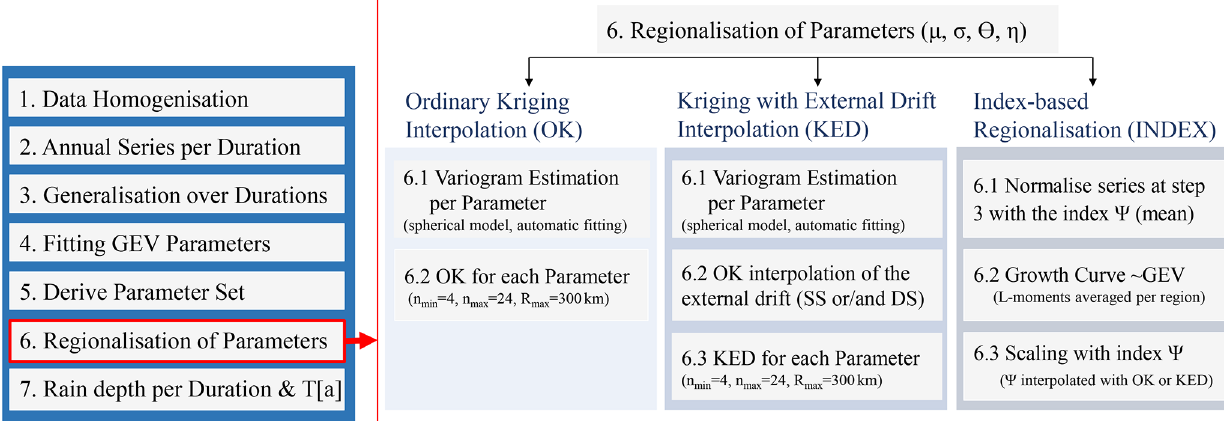
Figure 7. (a) The step-by-step methodology applied here from the given point datasets to the final regionalised rainfall depths over all du- rations and return periods (T[a]) in Germany; (b) a detailed procedure for step 6 – regionalisation (shown in red) only for the parameters of KO.FIX (see Table 5) carried out with different methods (ordinary kriging – left, external drift kriging – middle, and index-based regionali- sation – right). The parameters interpolated are the GEV (location µ and scale σ ) and Koutsoyiannis ( θ and η ) parameters. For both kriging methods, for each parameter, first a spherical variogram is estimated (step 6.1) and the interpolation is performed (steps 6.2 or 6.3) with the given n min , n max and R max which are the kriging parameters for minimum, maximum number of neighbours and maximum radius for neighbour search. For index-based regionalisation, first the generalised series obtained in step 3 are normalised with the index (cid:57) (step 6.1), next a regional GEV growth curve for each homogeneous region is derived based on regional L-moments (step 6.2), and finally the quantiles at each duration are rescaled with the index (cid:57) (step